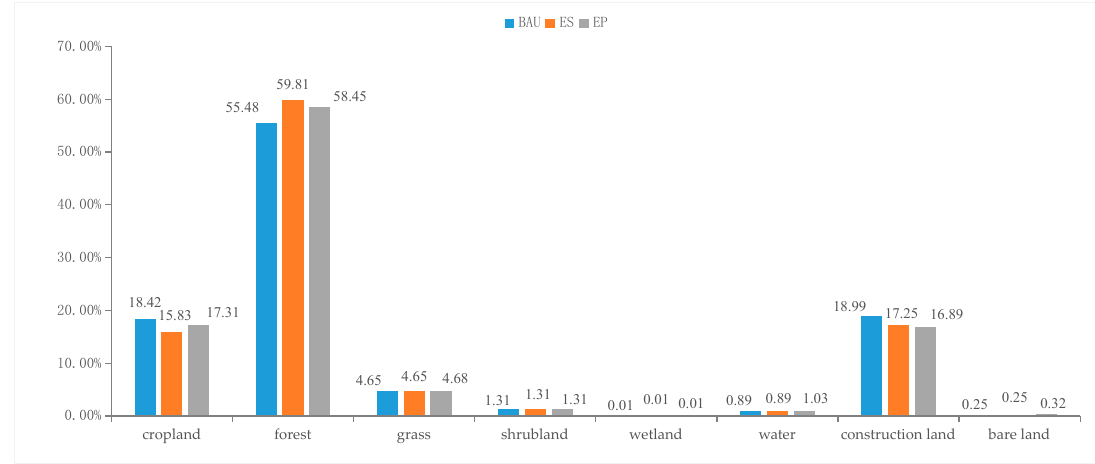
Figure 9. Land-use structure comparison of Beijing in 2031 under different scenarios.